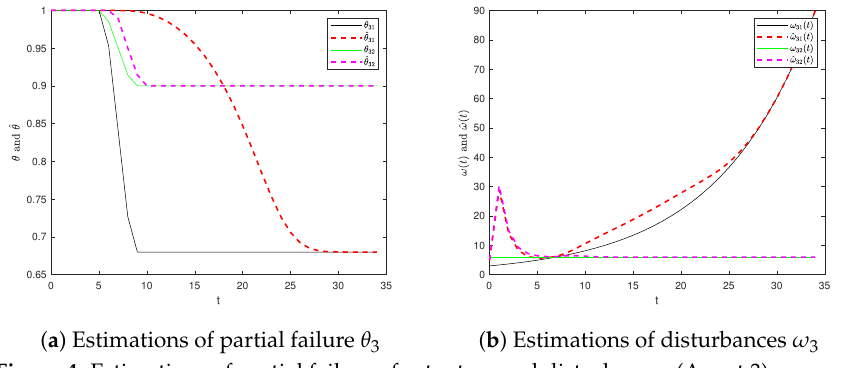
Figure 4. Estimations of partial failure of actuators and disturbances (Agent 3).